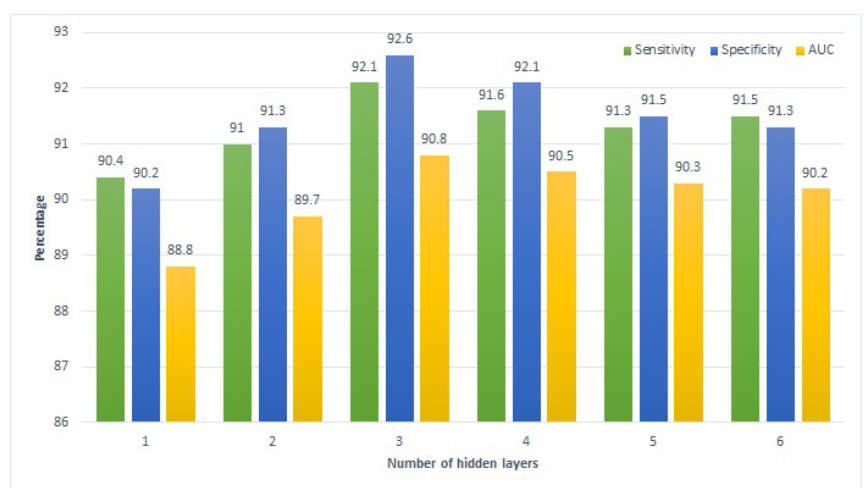
Figure 6. Performance of the proposed approach on home tutoring.